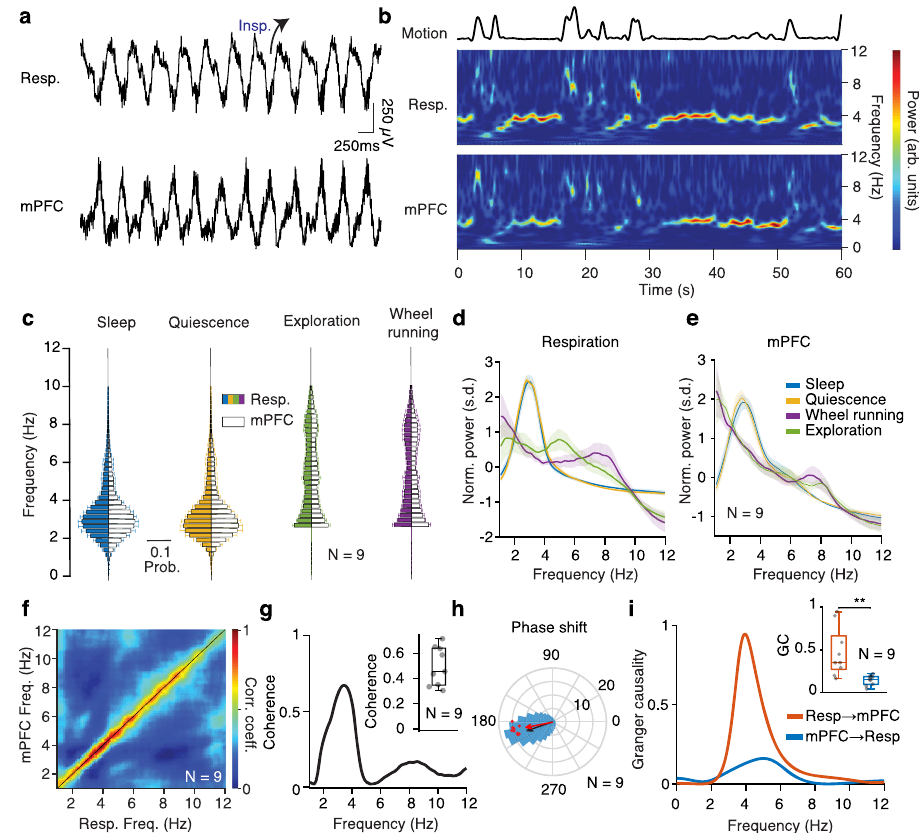
Fig. 1 Prefrontal oscillations are related to breathing throughout behavioral states. a Example traces of simultaneously recorded respiratory olfactory EEG and medial prefrontal local fi eld potentials (LFP) in freely-behaving mice. b Example time-frequency decomposition of respiratory and mPFC LFP signals, revealing the reliable relationship between the two signals. Top, the motion amplitude of the mouse at each time point. c Distribution of peak frequency bins of the spectrally decomposed respiration (left; darker colors) and mPFC LFP (right; lighter colors) during slow-wave sleep, quiescence, exploratory behavior, and self-initiated wheel running ( N = 9 freely-behaving mice). d , e Averaged normalized power spectral density of respiration ( d ) and mPFC LFP ( e ) across states as in ( c ). f Frequency-resolved comodulation of respiration and mPFC LFP oscillation power, across mice and behaviors ( N = 9 freely-behaving mice). g Example coherence spectrum between respiration and mPFC LFP during of fl ine states. Inset, average coherence value in the 2 – 5 Hz band ( N = 9 freely-behaving mice). h Phase shift of 2 – 5 Hz fi ltered respiration and mPFC LFP signals during of fl ine states for an example animal (blue histogram) and overlaid magnitude of phase modulation (logZ) and average phase shift for all animals (red dots; N = 9 freely-behaving mice). Black arrow depicts the average phase and logZ of the phase shift for the example and the red arrow for the population. i Example spectral Granger causality between respiration and mPFC LFP for both causal directions. Inset, group statistics of the average Granger causality for the 4 Hz band (2 – 5 Hz) between respiration and mPFC LFP for both causality directions ( N = 9 freely-behaving mice, Wilcoxon signed-rank two-sided test, resp → mPFC versus mPFC → resp, P = 0.0039, ** P < 0.01). For box plots, the middle, bottom, and top lines correspond to the median, bottom, and top quartile, and whiskers to lower and upper extremes minus bottom quartile and top quartile, respectively. arb. units arbitrary units, s.d. standard deviations. Shaded areas, mean ± SEM. Source data are provided as a Source Data fi